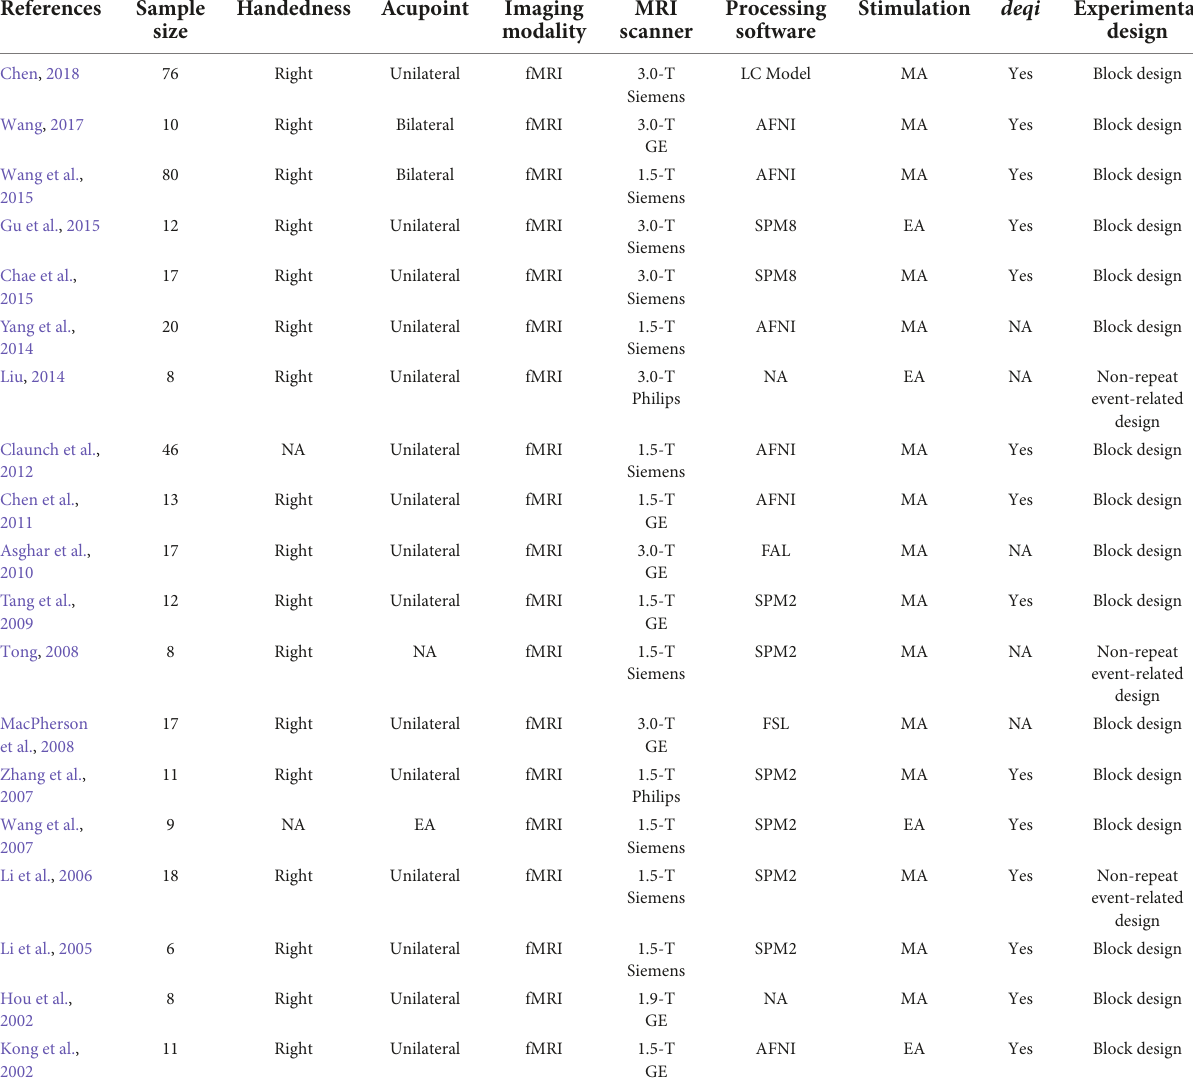
TABLE 1 Studies entered into the meta-analysis are listed based on the year of publication.